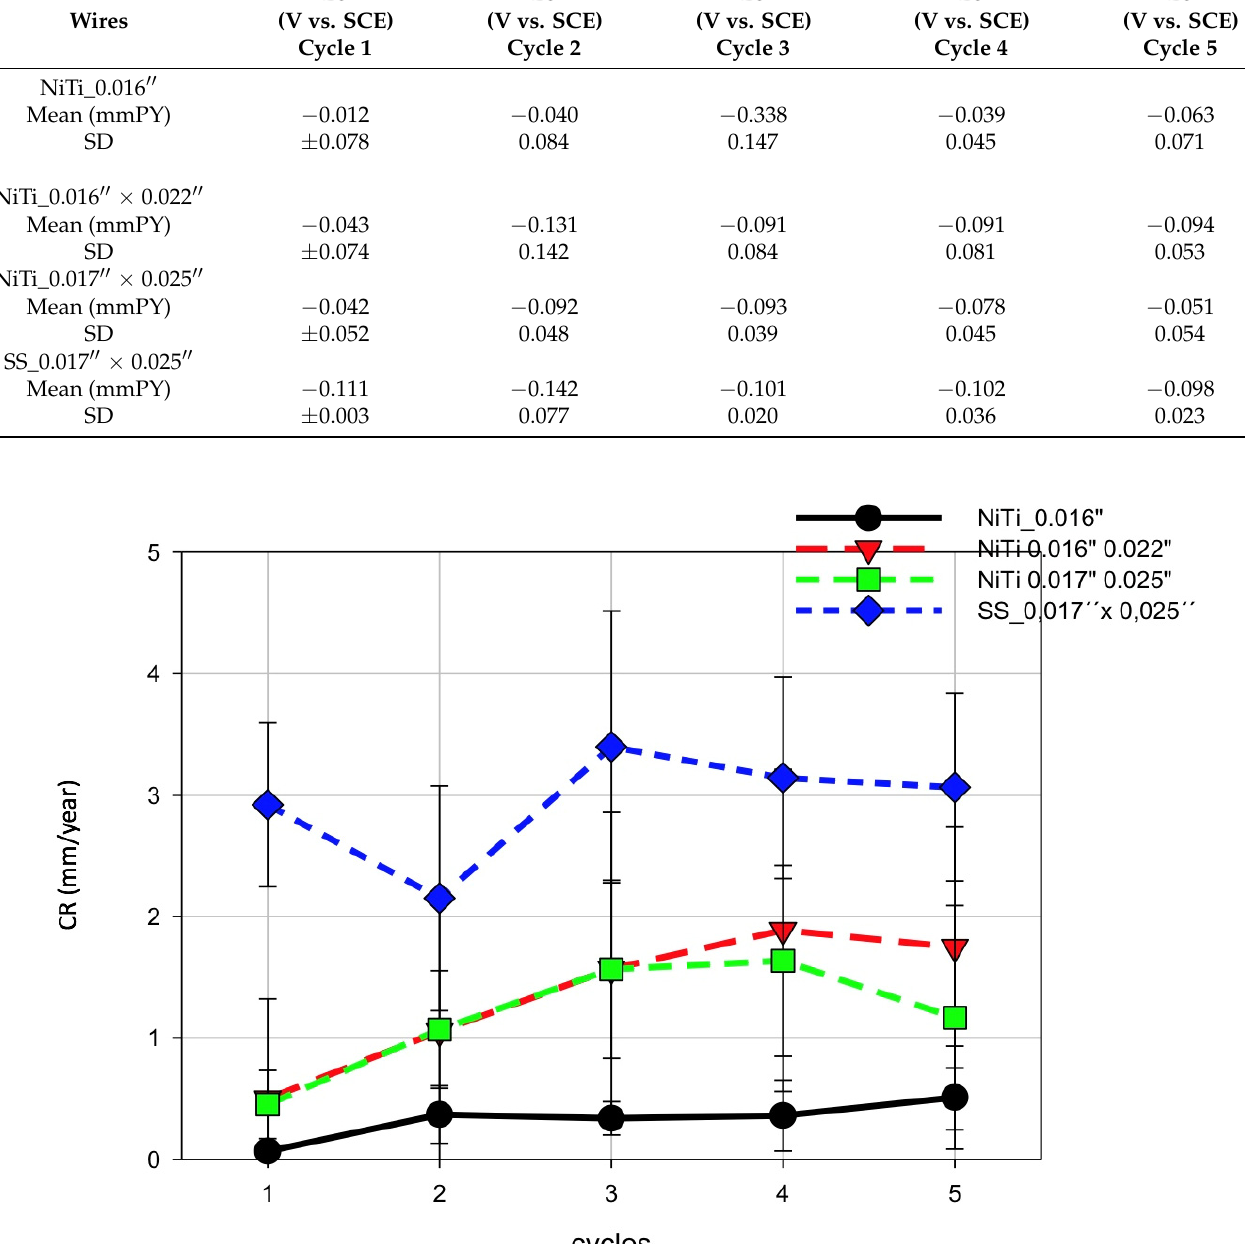
Figure 11. ( a ) Mean CR of wires being tested. ( b ) Mean E corr of wires being tested in Ringer’s solution at pH = 1 and RT. It was observed that the higher the negative value of E corr , the greater the CR of the wires.